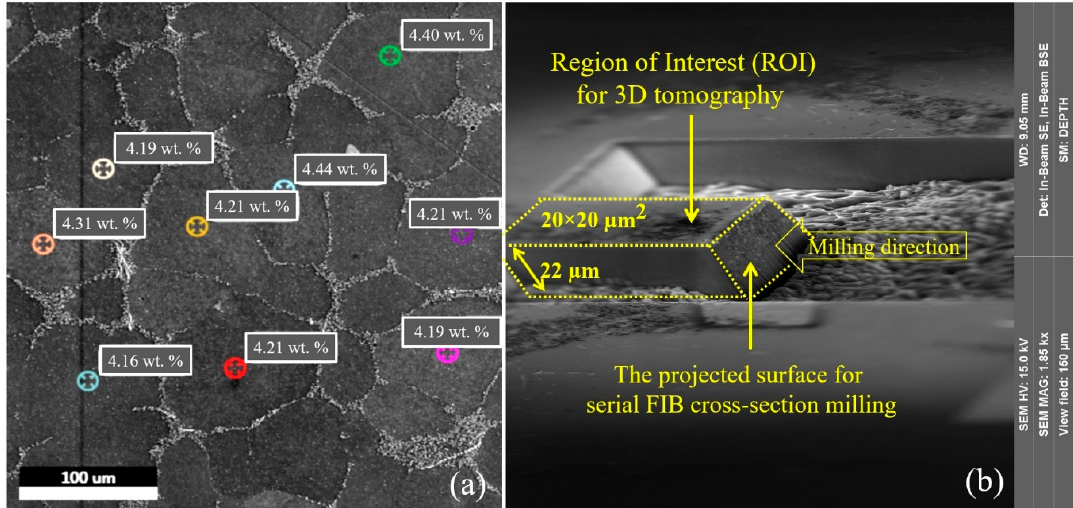
Figure 2. ( a ) An example of the measured Cu-solute level in the center of α -Al grains using wavelength-dispersive X-ray spectroscopy (WDS) technique. ( b ) Scanning electron microscopy (SEM) micrograph (secondary electron) on the trench with focused ion beam (FIB) milled around the bulk which undergoes serial FIB cross-section milling.